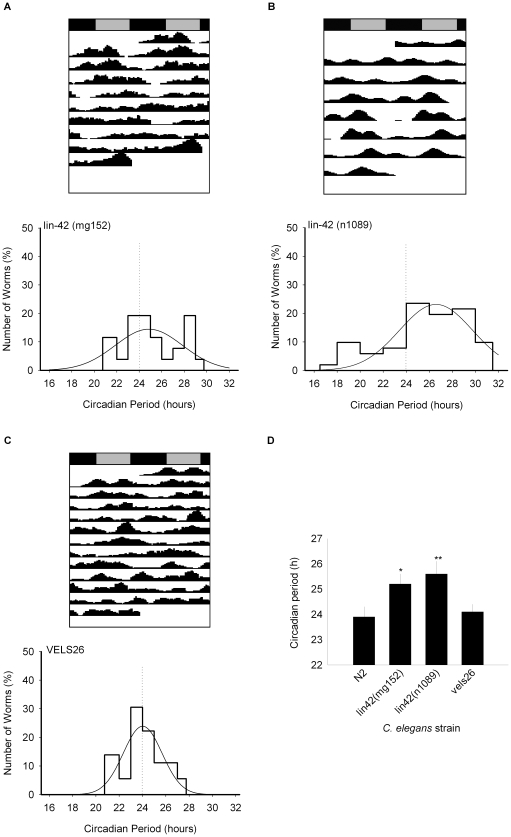
Representative actograms and frequency distribution of circadian periods in C. elegans.a) lin-42(mg152) mutants (n = 26). b) lin-42(n1089) mutants (n = 51). c) Vels26 mutants (which rescue the lin-42(mg152) mutation) (n = 36). d) Average circadian periods for control and mutant strains (*p<0.05, **p<0.02 versus N2 controls).